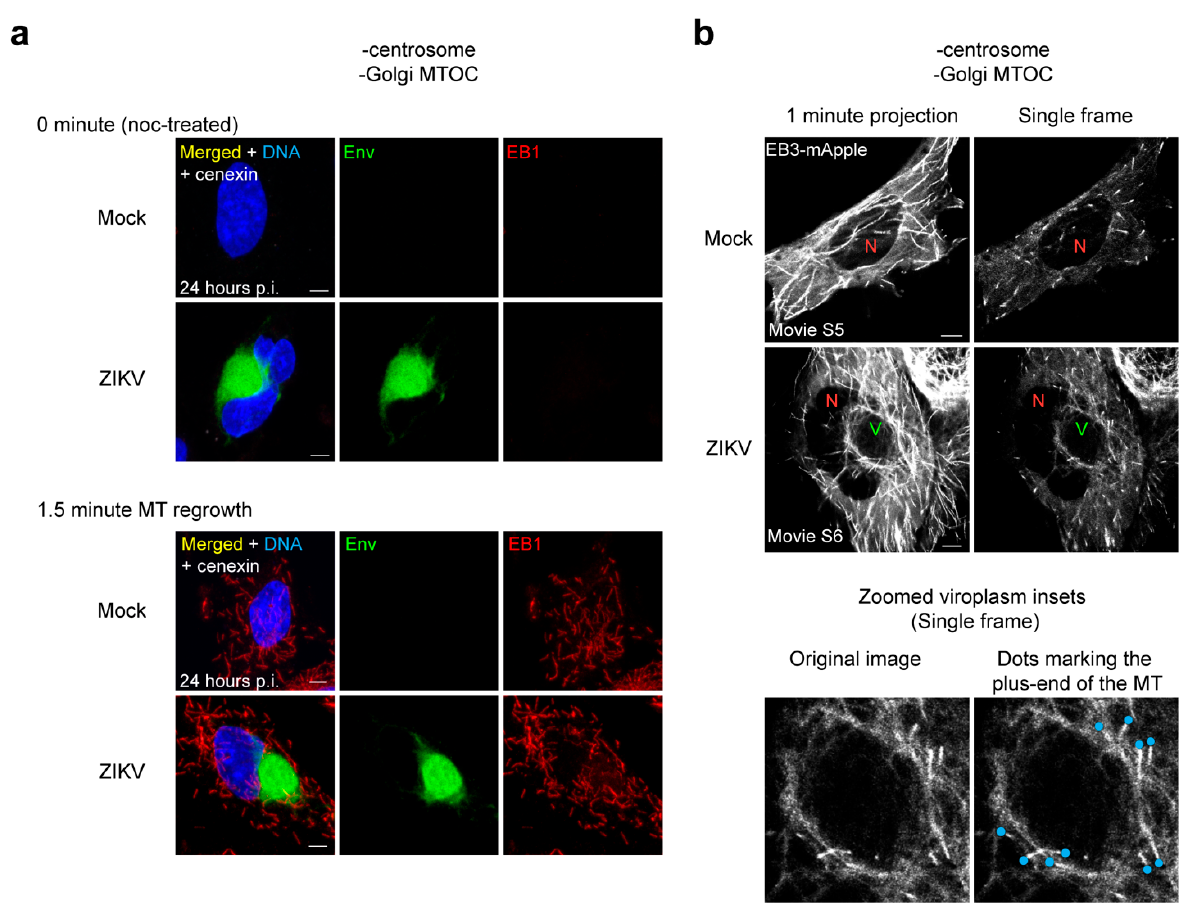
Figure 5. MTs are anchored at the ZIKV viroplasm ( a ) MT regrowth assay. A total of 0 min (noc-treated) and 1.5 min regrowth of centrinone-treated AKAP450 KO mock- and ZIKV(MR766)-infected SNB19 cells (-centrosome/-Golgi MTOC). Representative IF images of centrinone-treated AKAP450 KO mock- and ZIKV-infected cells from two independent experiments that show MTs as marked by MT-plus end protein EB1 regrowing randomly throughout the cytoplasm (mock, n = 8 imaged cells; ZIKV, n = 30 imaged cells). Viroplasms are marked by Env (green). DAPI labels the nucleus (blue); ( b ) Live imaging of MT-plus end protein EB3-mApple (white) of mock (Movie S5) and ZIKV-infected centrinone-treated AKAP450 KO (Movie S6) cells. The left panel shows 1 min projection of EB3 comets, and the right panel shows a single frame of the movie. Red ‘N’ indicates the nucleus, and green ‘V’ indicates the viroplasm. Zoomed inset of the viroplasm from a single frame of the movie shows EB3 comets (original image (left), marked image with blue dots off the growing plus-ends of MTs (right)) coming from the viroplasm. The cells were imaged for 1–2 min with 4 s per frame. Mock- and ZIKV-infected movies are representative of 10 and 24 movies, respectively, from four independent experiments that show similar MT dynamics in each condition; scale bars: 5 μ m.